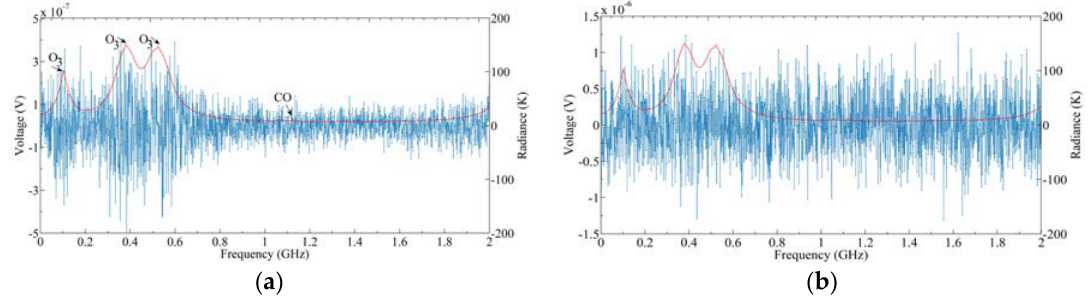
Figure 8. Signal spectrum of the scene target in front of the 240 GHz S5 spectrometer: ( a ) Tsys = 0 K; ( b ) Tsys = 1000 K.